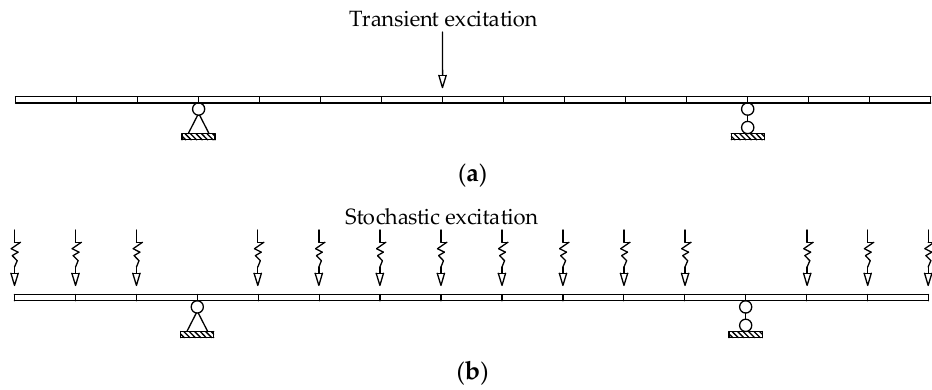
Figure 3. Schematic diagram of excitation applied on the beam: ( a ) transient excitation; ( b ) stochastic excitation.